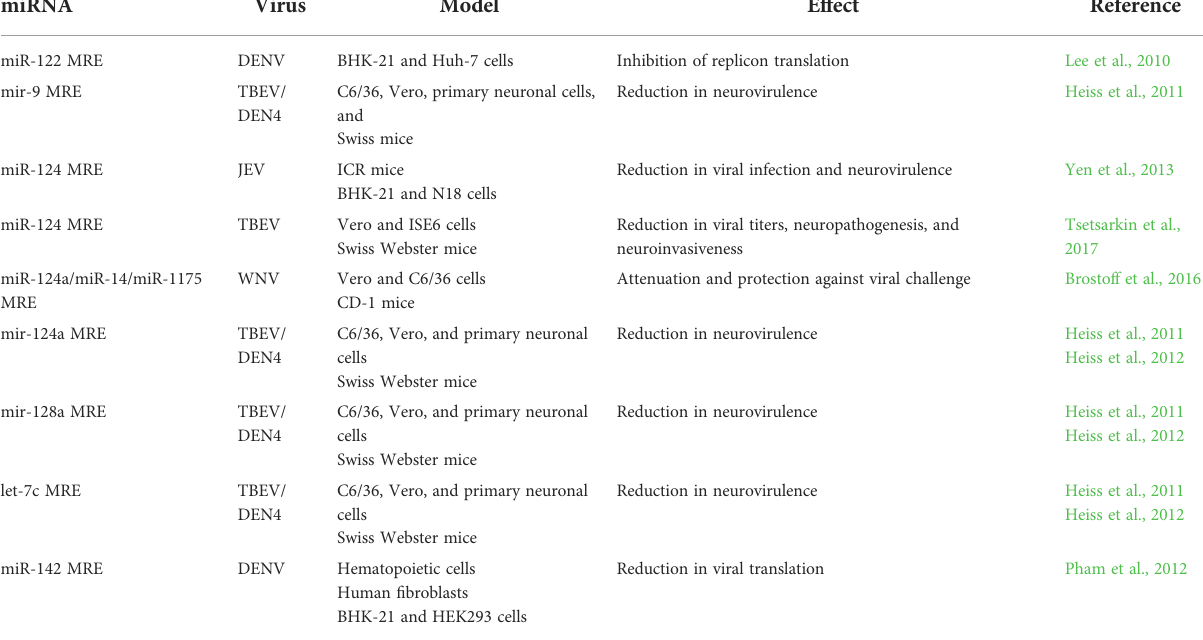
TABLE 2 miRNA recognition element arti fi cially inserted in fl avivirus genomes.